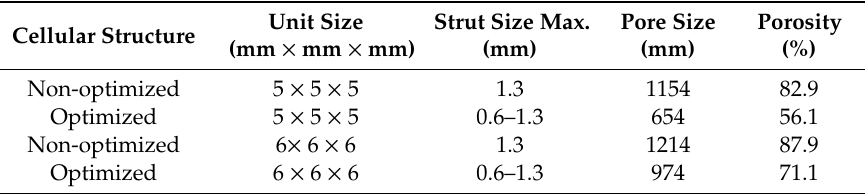
Table 2. Cellular structures for compression testing.